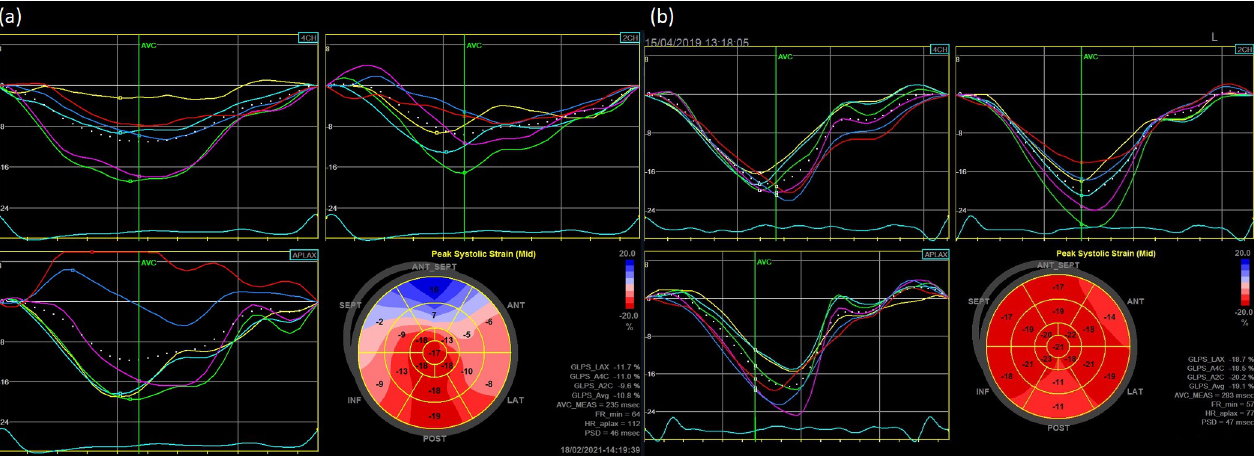
Fig 4. Example of the longitudinal strain bull’s eye plot derived from two-dimensional speckle tracking imaging in patients admitted with an initial diagnosis of anterolateral STEMI and with the final diagnosis of myocardial infarction resulted from occlusion of the left anterior descending artery (a) and acute myocarditis